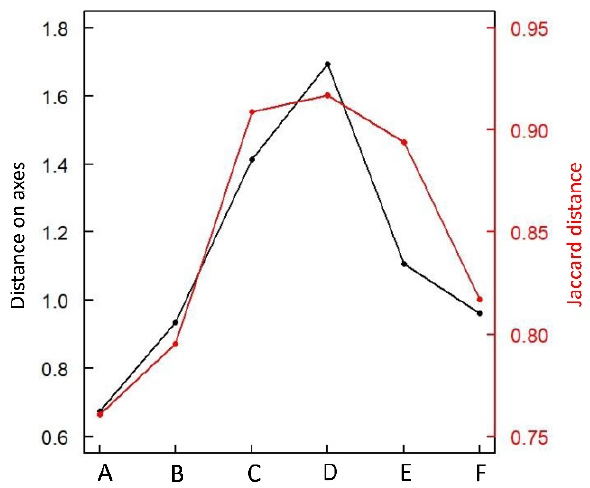
Figure 8. Mean dissimilarities between the prefire and postfire bird assemblages in samples belonging to a grassland-to-forest gradient (vegetation types A to F; see Figure 2). The dissimilarities were measured between the prefire and the first postfire samples either by Jaccard distance (in red), or by the sum of the distances on the first three axes of the correspondence analysis (in black). Repeated fires were not taken into account.